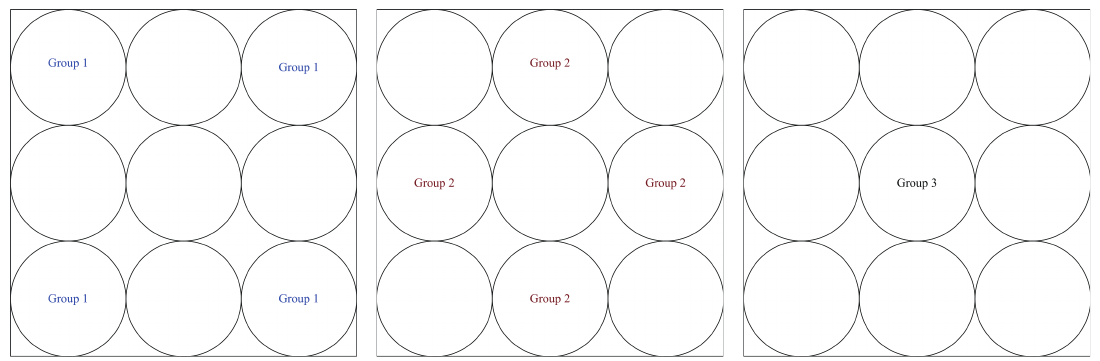
Figure 7. Three possible locations of the source; group 1 (left), group 2 (middle), group 3